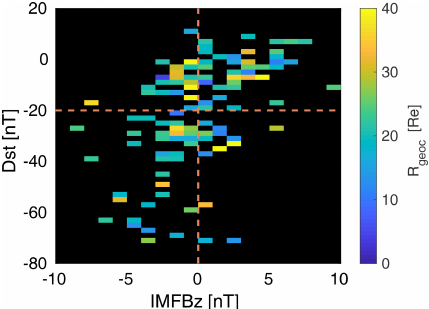
Figure 7. Geocentric final positions of all O + ions (colour bar) as a function of geomagnetic activity (Dst) and IMF B z direction. The horizontal and vertical dashed lines divide quiet (top) from disturbed (bottom) geomagnetic activity and southward (left) from northward (right) IMF